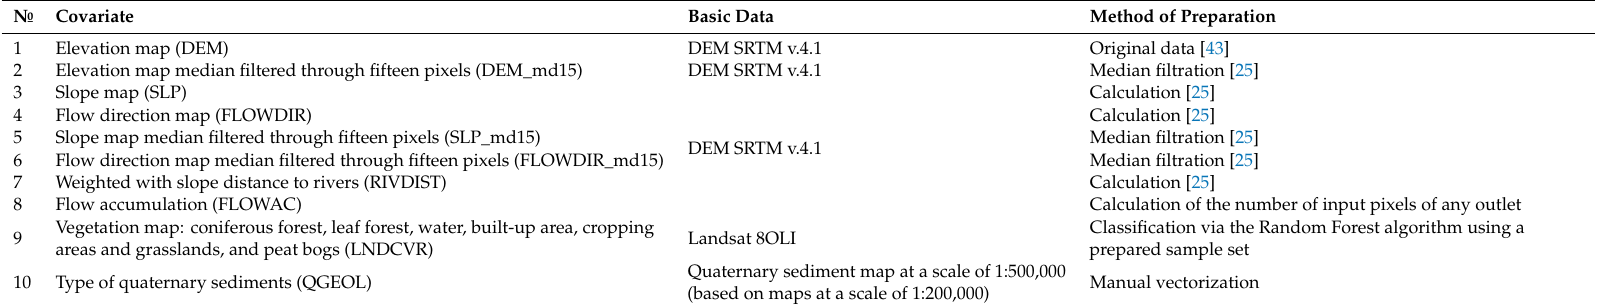
Table 3. Description of the developed